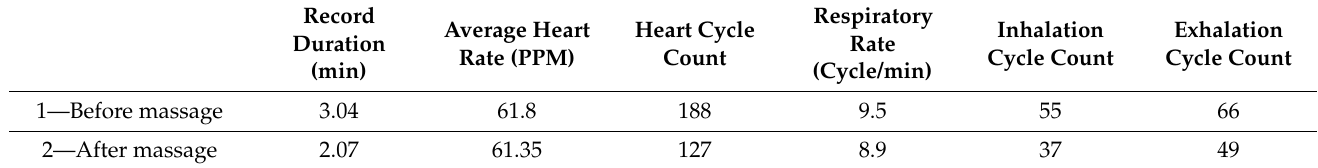
Table 1. General data about recorded signals before and after